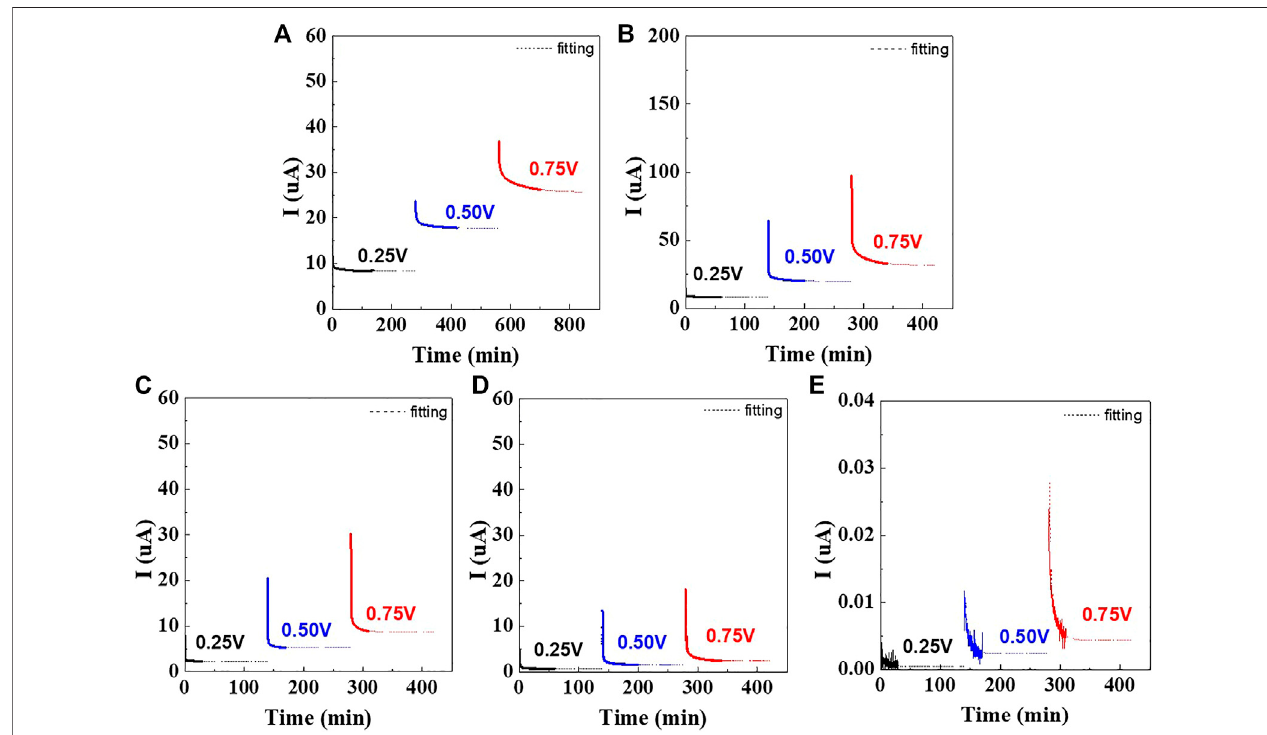
FIGURE4| DCpolarizationcurvesofsymmetricalcellscontainingwet-milledLi 6 PS 5 Clelectrolytespreparedusing (A) hexane, (B) heptane, (C) toluene, (D) xylene, and (E) dry-milled Li 6 PS 5 Cl electrolyte.